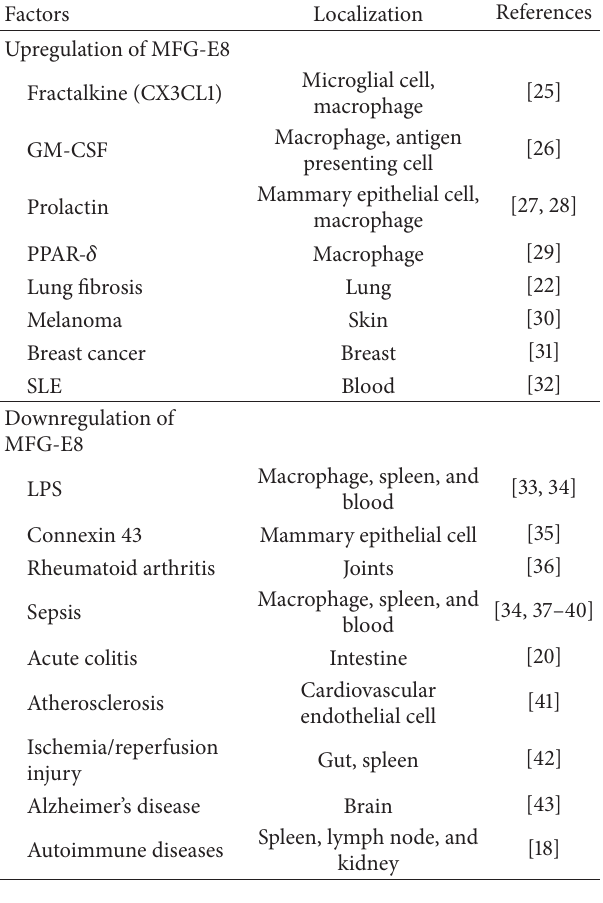
Table 1: Altered expression of MFG-E8 in human diseases. Factors